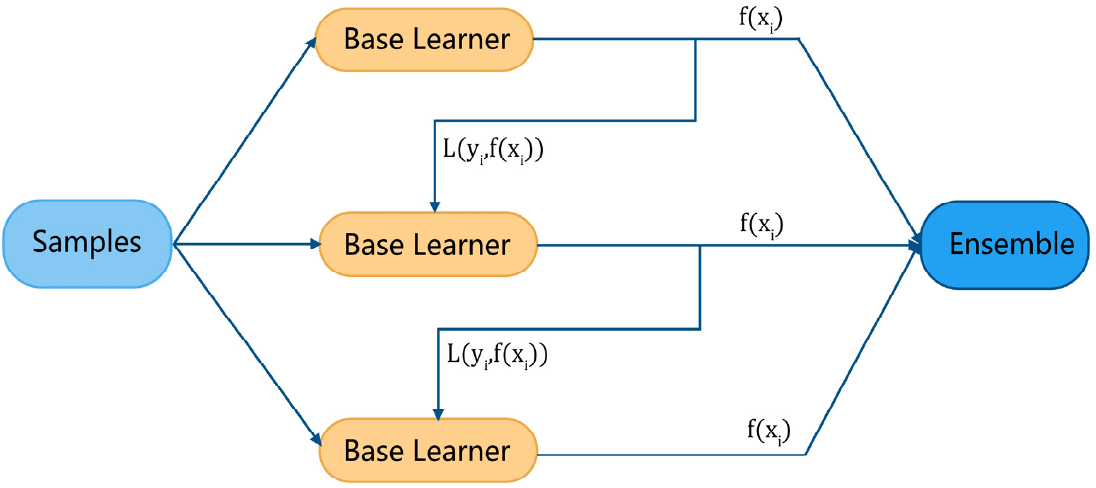
Figure 4. Boosting algorithm modeling